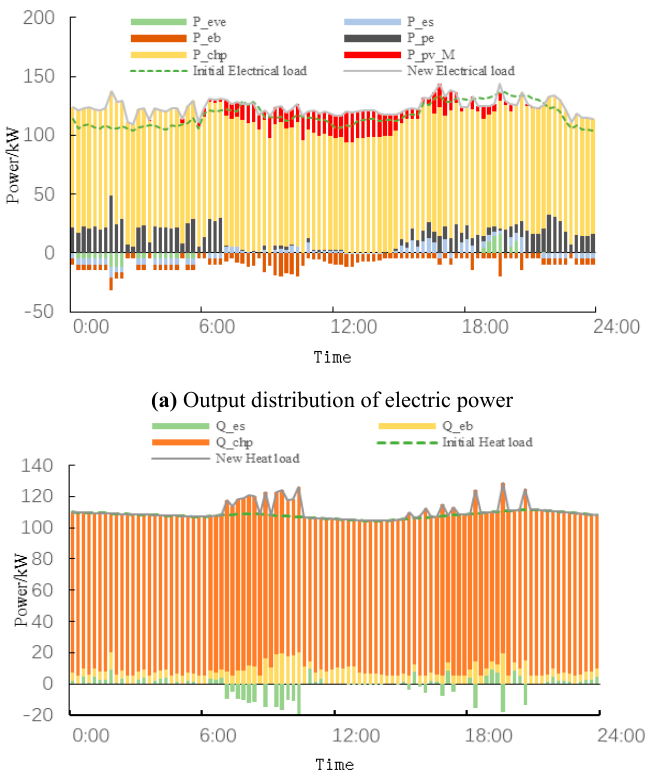
Figure 5. Output distribution in IESP.